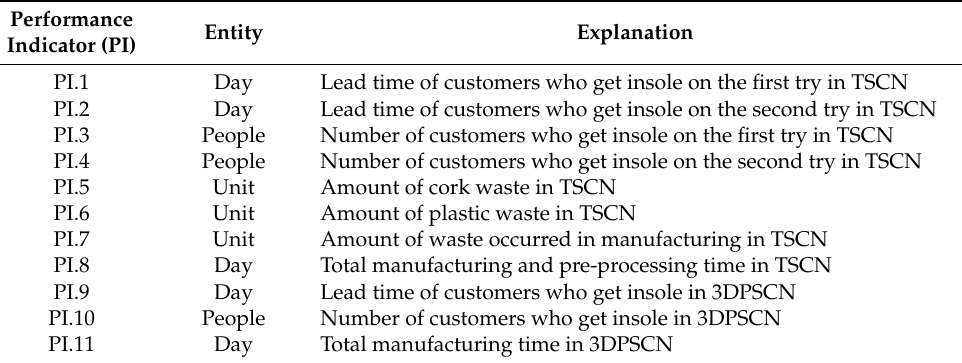
Table 3. Performance indicators of the simulation